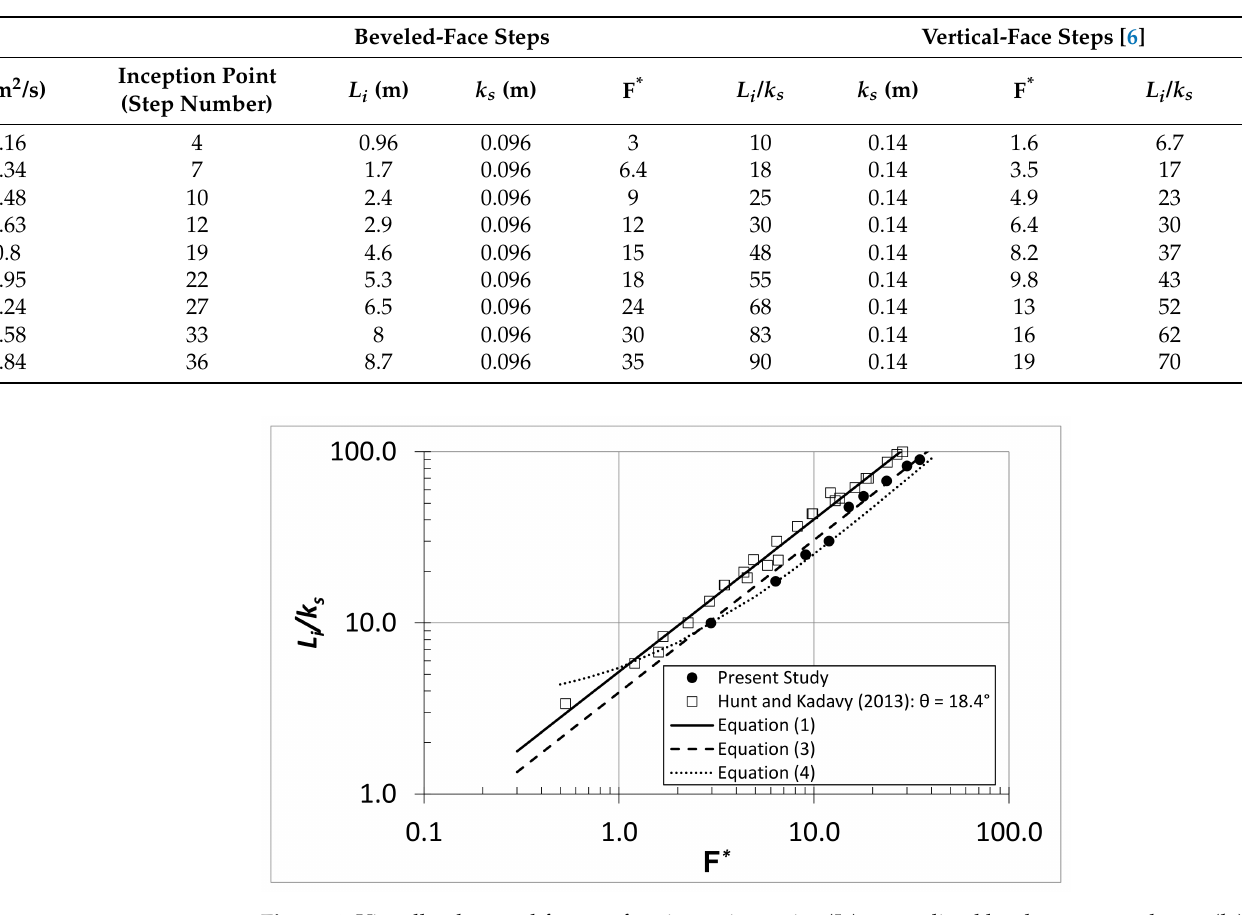
Table 2. Observed inception point location relative to step location, distance to the free-surface inception point, L i , and free-surface inception point to surface roughness ratio, L i / k s .